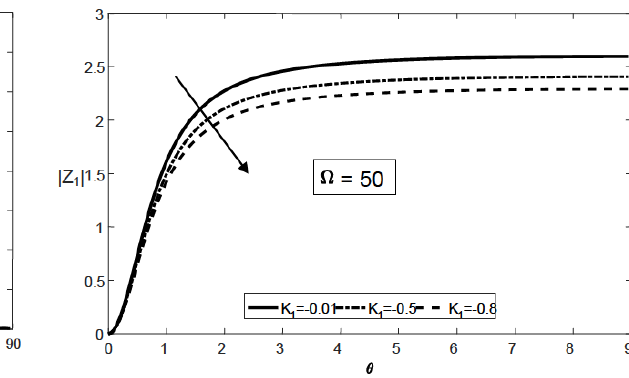
Figure 4: The amplitude ratio of the third wave against incident angle